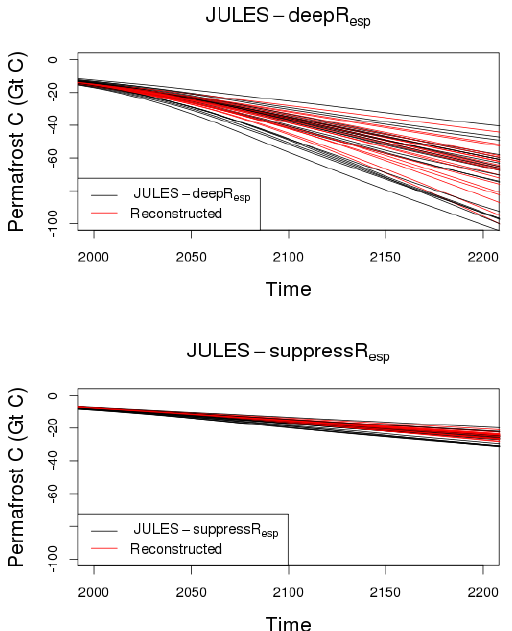
Figure 12. Time series of permafrost carbon loss for the RCP4.5 scenario. The black lines show the JULES simulations, and the red lines show the reconstruction using the initial permafrost carbon, the time series of global mean temperature change and the parameters from Table